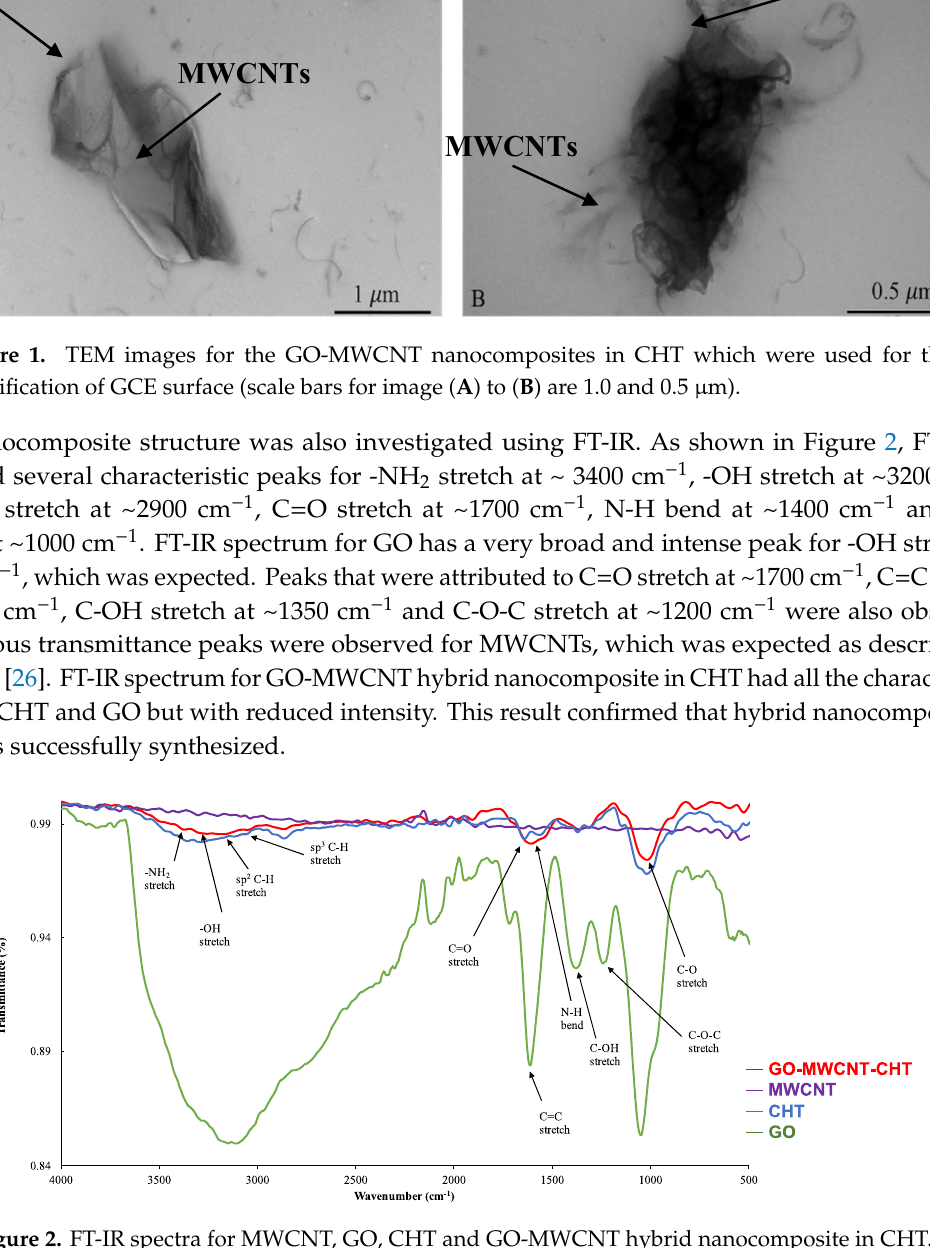
Figure 2. FT-IR spectra for MWCNT, GO, CHT and GO-MWCNT hybrid nanocomposite in CHT.